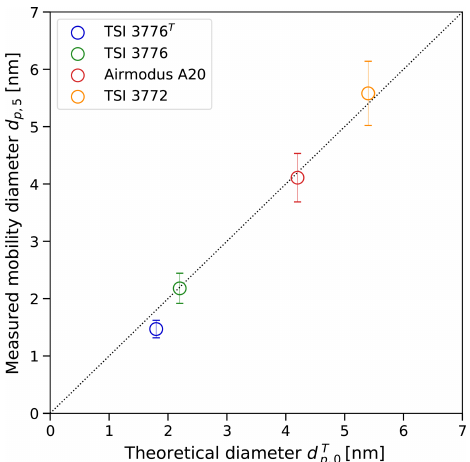
Figure 7. Theoretical diameters: the figure shows the theoretically minimal diameters necessary for particle activation of neutral silver seeds as a function of the measured 5% cutoff diameter for nega- tively charged silver seeds. Every color corresponds to a different particle counter. Data points on the dashed line stand for the equal- ity of the theoretical and measured